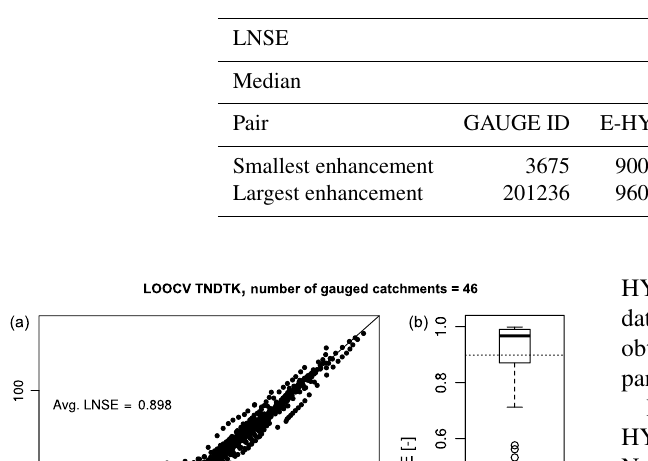
Table 2. Nash–Sutcliffe Efficiencies computed on log-transformed daily streamflows for E-HYPE and GAE-HYPE: median values for the 11 prediction nodes considered in the study; smallest enhancement (IDs 3675 – 9001070), largest enhancement (IDs 201236 – 9608296).